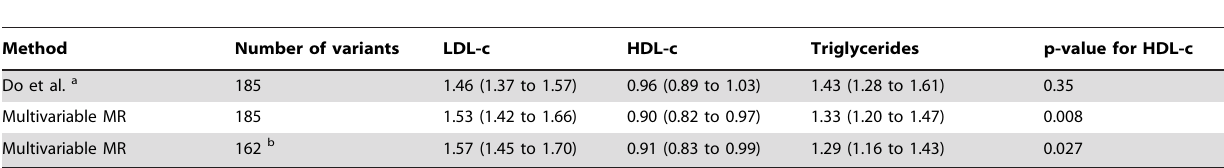
Table 1. Causal odds ratios (95% confidence/credible intervals) of coronary artery disease per standard deviation increase in each lipid fraction (low-density lipoprotein cholesterol, LDL-c; high-density lipoprotein cholesterol, HDL-c; and triglycerides), with two- sided p-value for